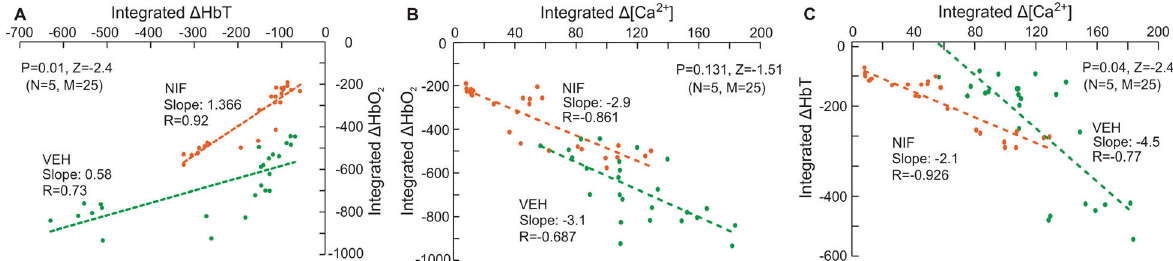
Fig. 4 Linear regression analyses for change in Δ HbT, Δ HbO 2 , Δ [Ca 2 + ] i signaling induced by cocaine. A Linear regression between cocaine- induced Δ HbT and Δ HbO 2 . B Linear regression between cocaine-induced Δ [Ca 2 + ] i and Δ HbO 2 . C Linear regression between cocaine-induced Δ HbT. Green markers: with vehicle treatment; Orange markers: with NIF pretreatment. Δ [Ca 2 + ] i and